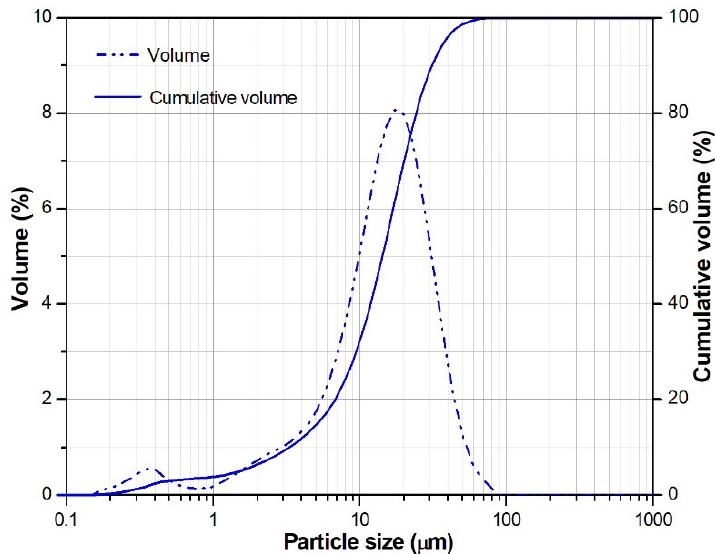
Table 1. Chemical composition (oxides in wt.%) of CSA cement.